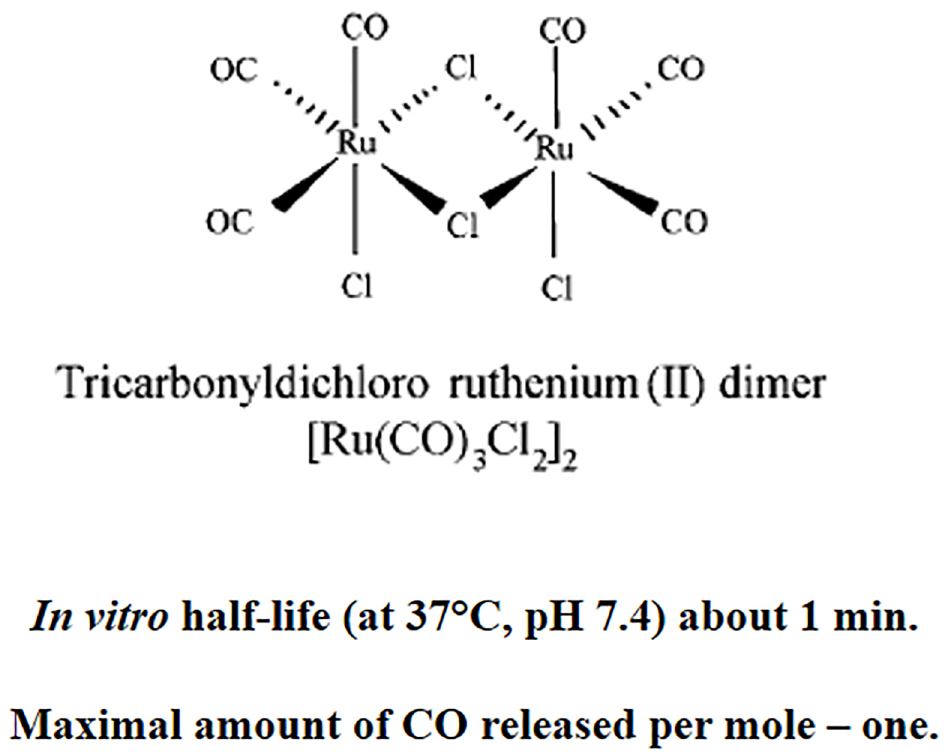
Fig 1. Chemical structure and characteristics of CORM-2 [14; modified].